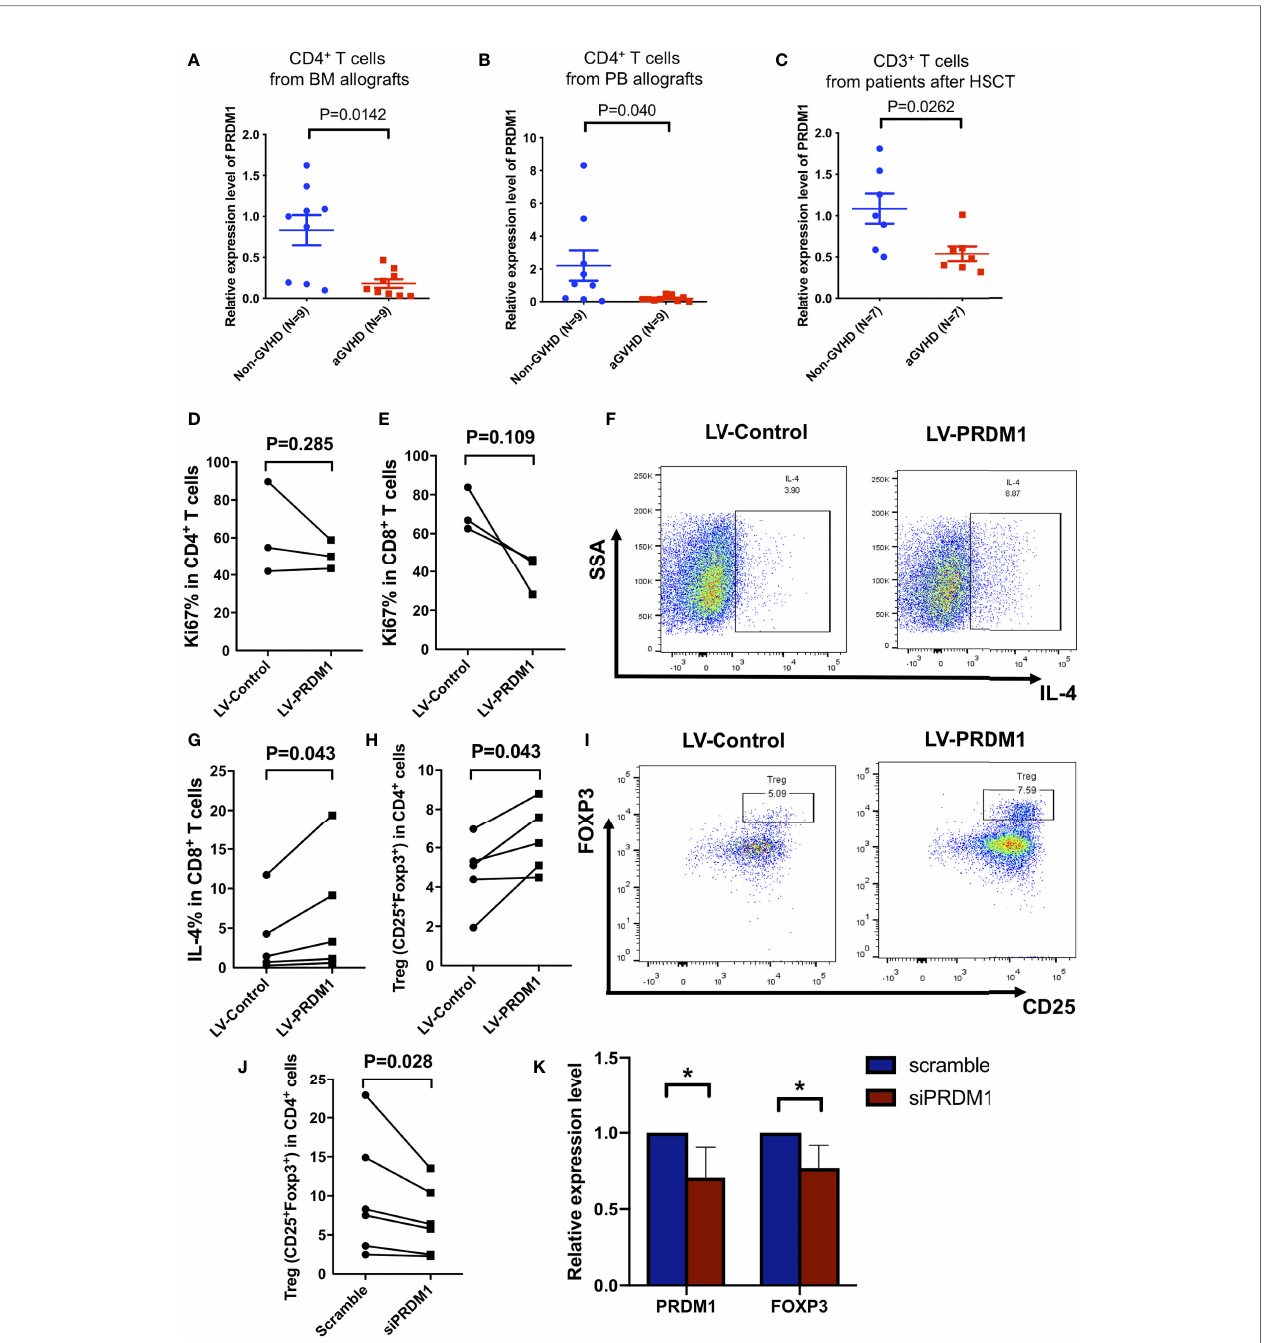
FIGURE 1 | High expression level of PRDM1 suppressed human primary T cell function. (A, B) Quantitative real-time PCR showed the expression level of PRDM1 in CD4 + T cells from bone marrow allografts (A) and from peripheral allografts (B) and the aGVHD occurrence in related patients, respectively. (C) The expression level of PRDM1 in peripheral CD3 + T cells in patients with aGVHD (n = 7) after allo-HSCT compared with those without aGVHD (n = 7) in the same period. Mann – Whitney U test was used for testing PRDM1 expression. (D, E) Flow cytometry results showed the percentage of Ki67 expression level on PRDM1 overexpressing CD4 + T cells (D) and CD8 + T cells (E) in GFP + population compared with control T cells (n = 3). (F, G) Representative fl ow cytometry results and percentages showed the IL- 4 secretion level of PRDM1 overexpressing GFP + CD8 + T cells compared with control T cells (n = 5). (H, I) Percentages and representative fl ow cytometry results showed the Treg cell subset (CD4 + CD25 + FOXP3 + ) in PRDM1 overexpressing GFP + CD3 + T cells compared with control T cells (n = 5). (J) Percentage of Treg cell subset in PRDM1 knocked down T cells compared with control T cells (n = 6). (K) Quantitative real-time PCR was used to detect PRDM1 and FOXP3 expression level in PRDM1 knocked down T cells compared with control T cells (n = 6). Wilcoxon rank sum test was performed to assess the signi fi cance in D-K. *P <